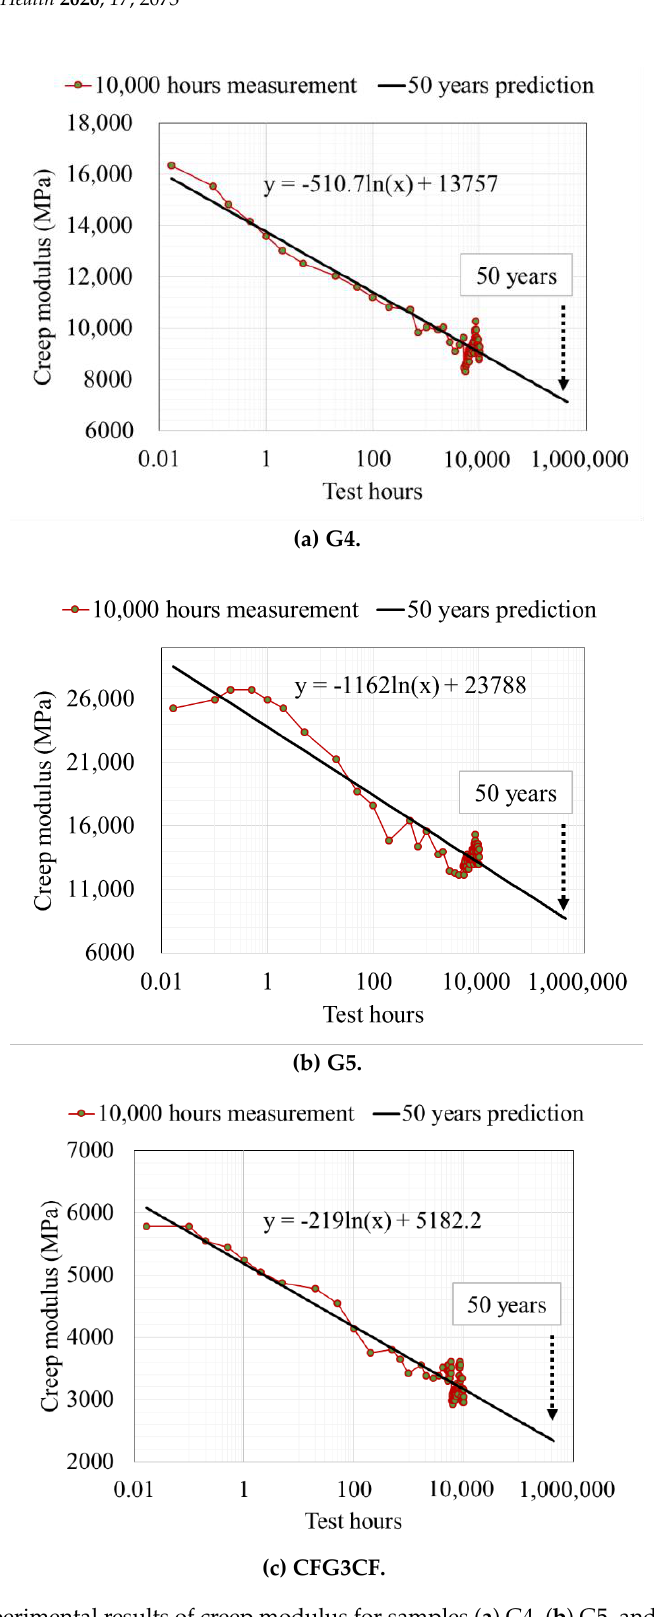
Figure 7. Experimental results of creep modulus for samples ( a ) G4, ( b ) G5, and ( c )